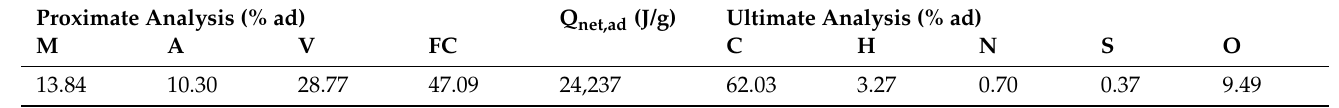
Table 1. Proximate and ultimate analyses of coal